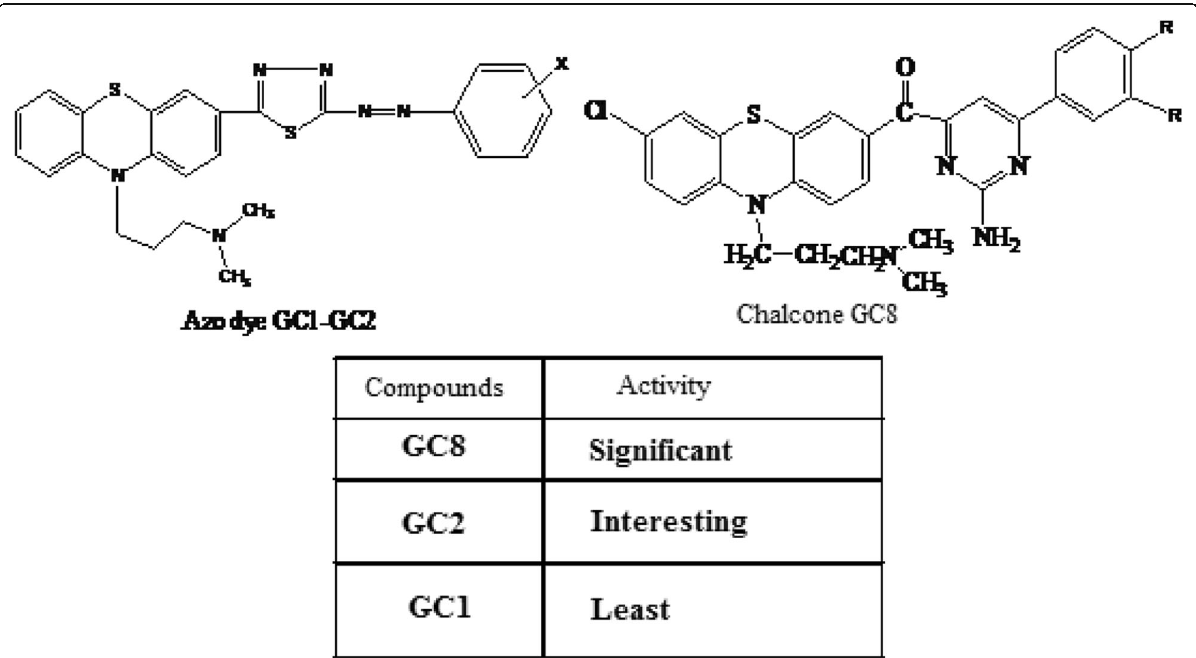
Fig. 7 Structural activity relationship of synthesised compounds related to brain dopamine